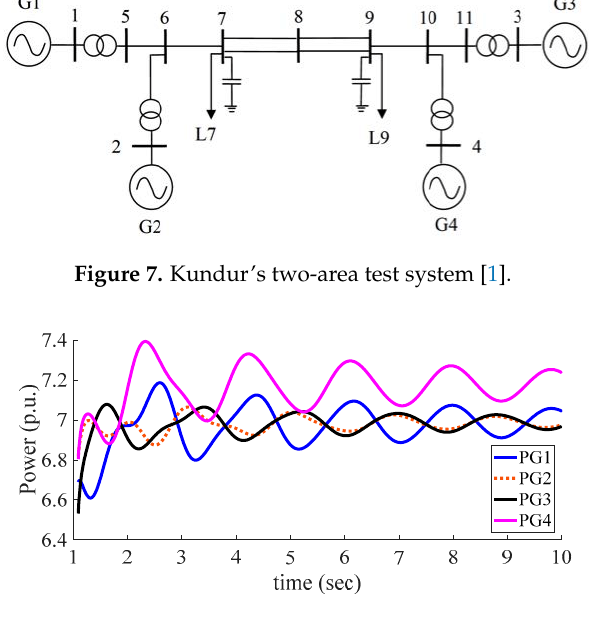
Figure 8. Power output of all generators related to Test Case 2.